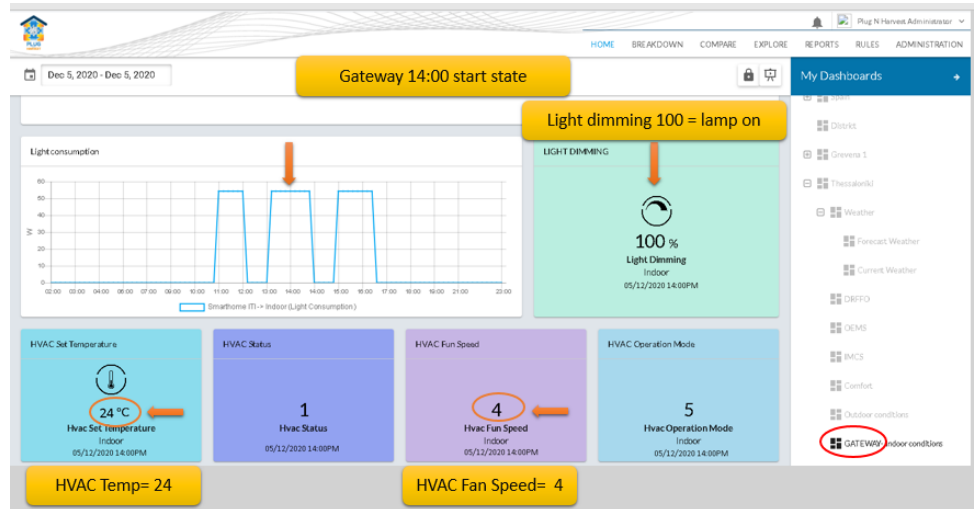
Figure 15. Current status data and information from the P-n-H Gateway.